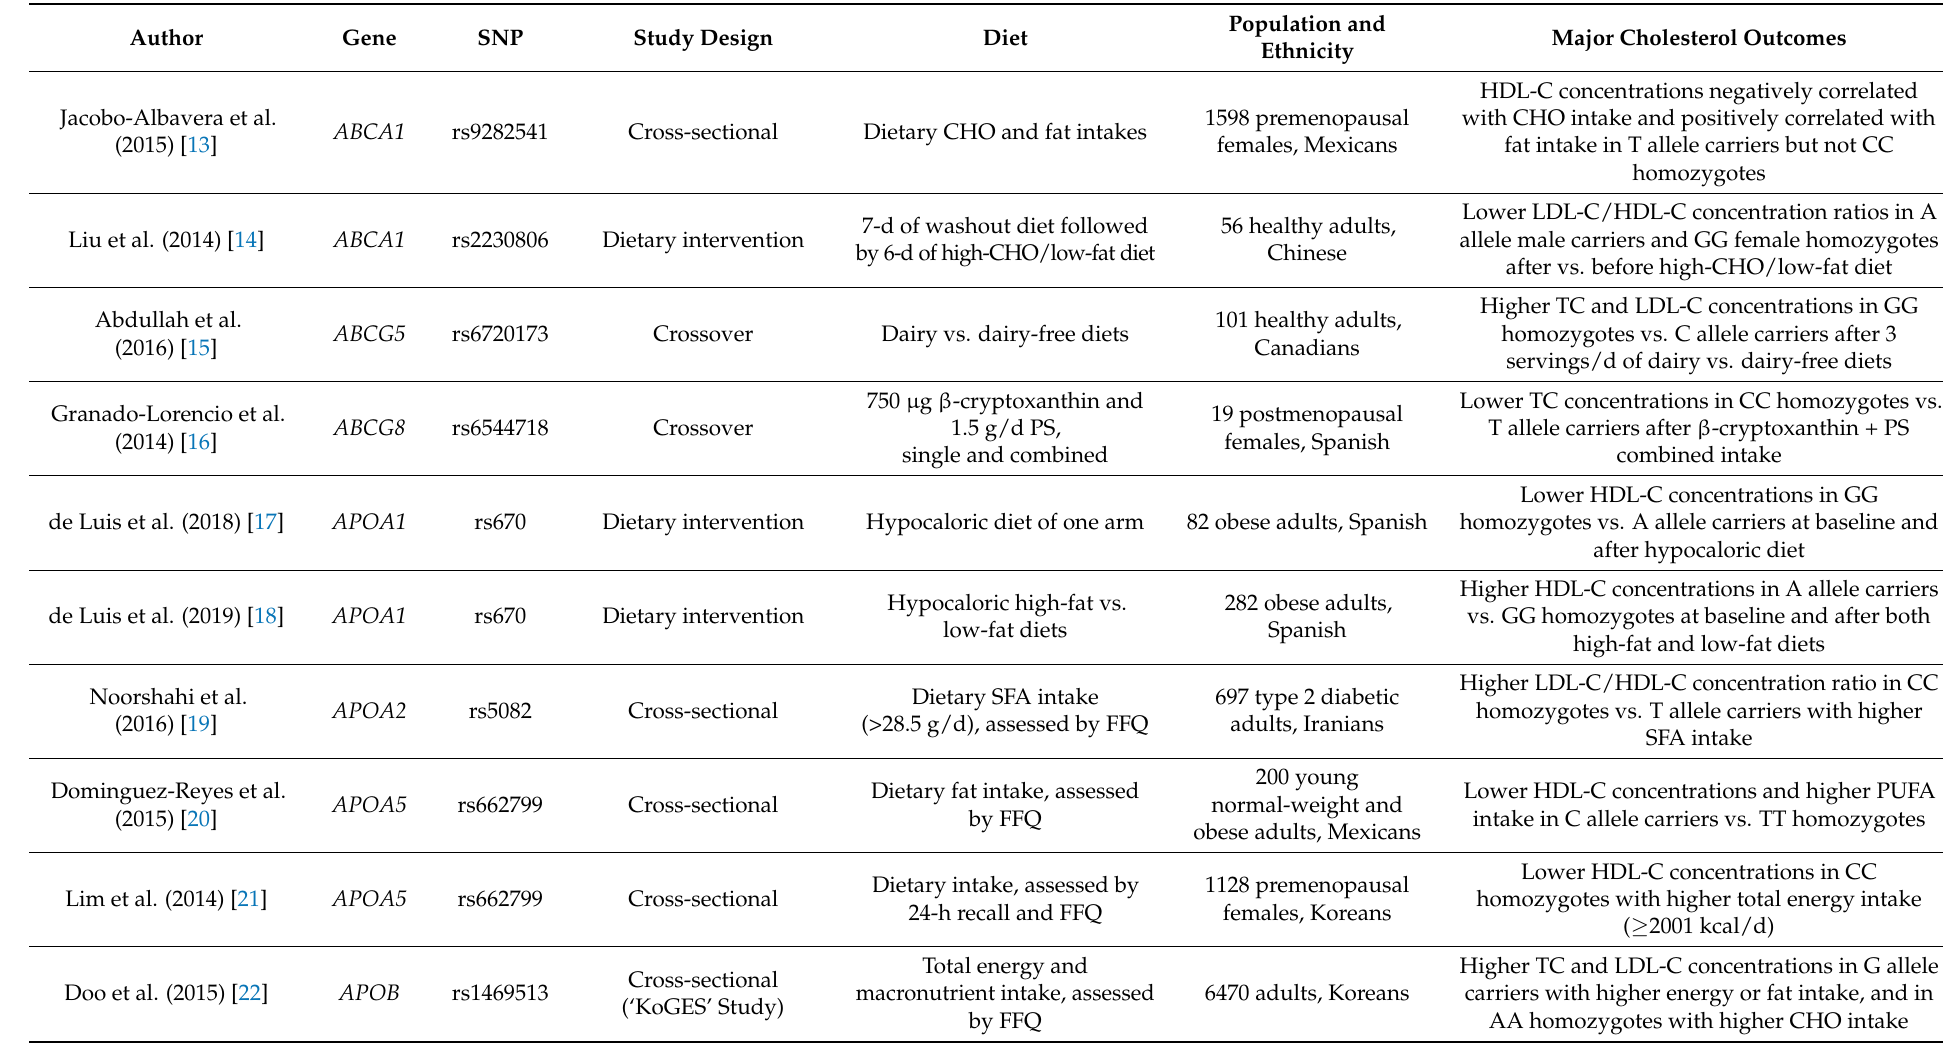
Table 1. Summary of epidemiological and dietary intervention studies reporting significant effects of individual SNP–diet interactions on circulating cholesterol